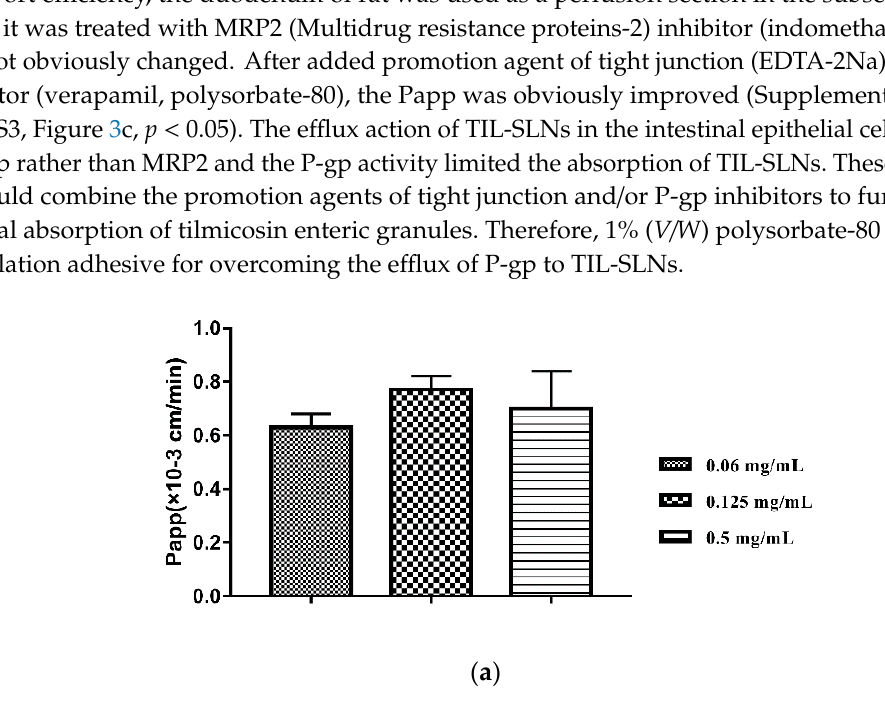
Figure 2. The SEM imaging of TIL-SLNs (tilmicosin-loaded solid lipid nanoparticles). The TIL-SLNs showed a spherical shape with a relatively narrow polydisperse.